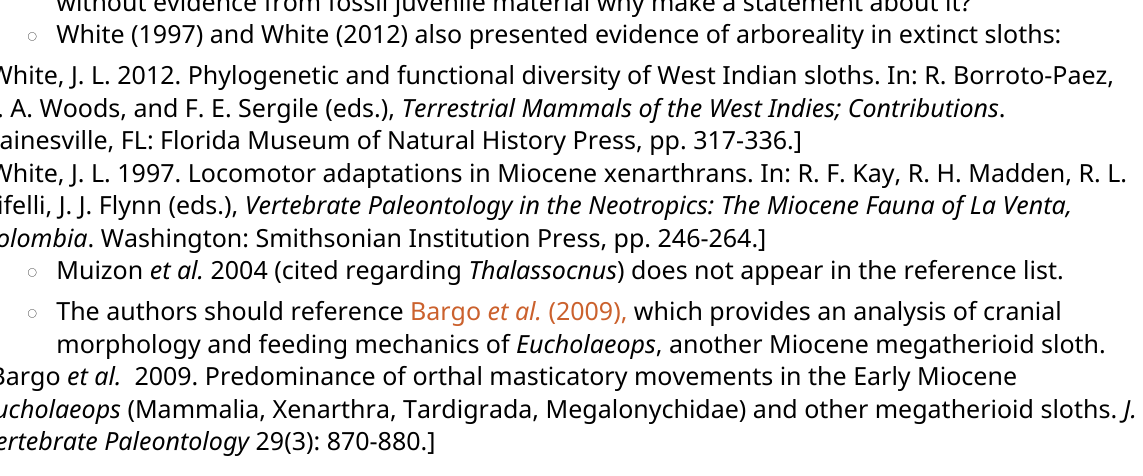
Figure 2: the caption has a spelling error in the word “osteological”. ○ The statement “ Animals with a farther lateral superior temporal line are probably younger, … ”